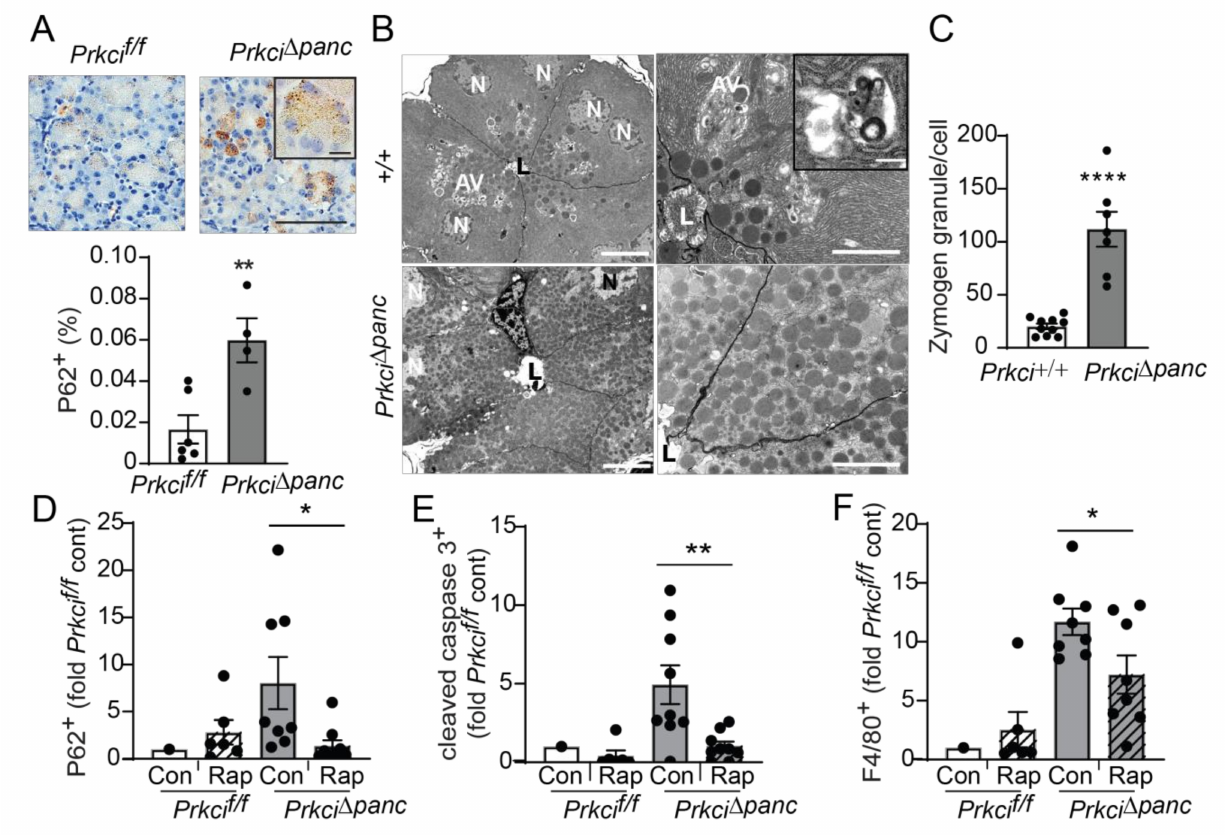
Figure 5. Pancreas-specific Prkci ablation blocks acinar cell autophagy. ( A ) IHC detection of P62 ag- gregates in pancreata of representative 1.5 month old Prkci f/f and Prkci ∆ panc mice (scale bar = 100 µ m, scale bar inset = 15 µ m). Quantitative analysis of IHC staining is plotted below images as mean ± SE; n = 4–7. ( B ) Representative images of transmission electron microcopy of pancreatic epithelial cells of 6 week old Prkci +/+ and Prkci ∆ panc mice at low (left images; scale bar = 10 µ m) and high magni- fication (right images; scale bar = 2 µ m). Inset shows a single membrane autophagic vesicle (scale bar = 333 nm). Lumen (L), nucleus (N), and autophagic vesicles (AV) are identified. ( C ) Quantitation of zymogen granules/cell is plotted as mean ± SE; n = 7. Control- and rapamycin-treated Prkc f/f and Prkci ∆ panc mice were analyzed by IHC for ( D ) P62 aggregates, ( E ) cleaved caspase-3, and ( F ) F4/80 expression in mouse pancreas. Quantitative analysis of IHC staining is plotted as mean ±